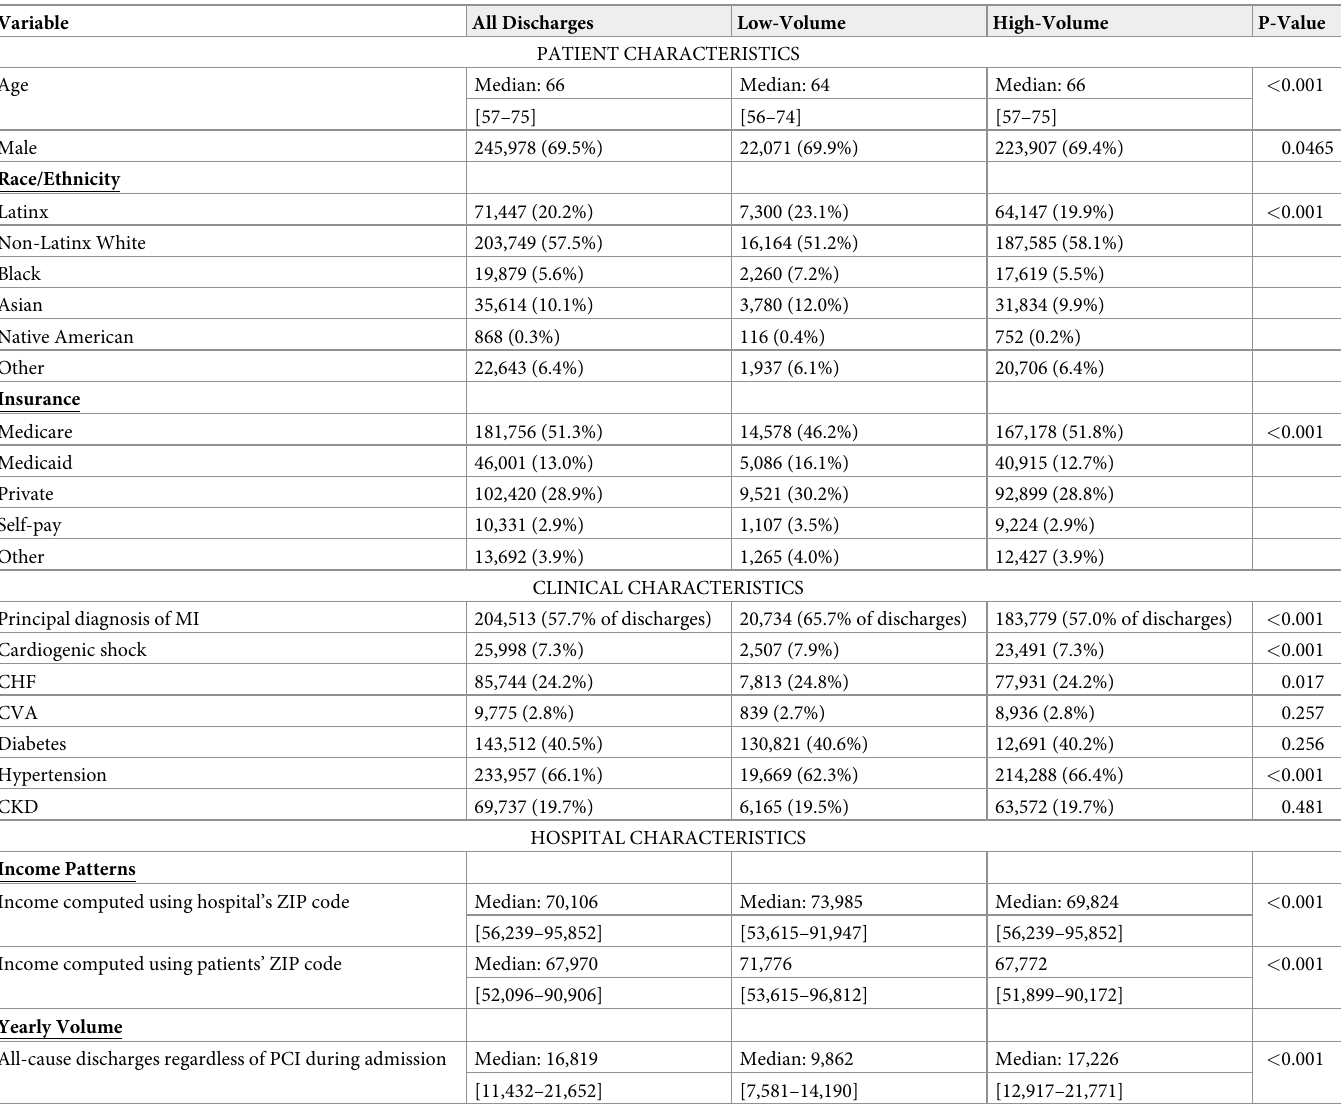
Table 1. Baseline demographics of patients receiving PCI (2010–18) (N =